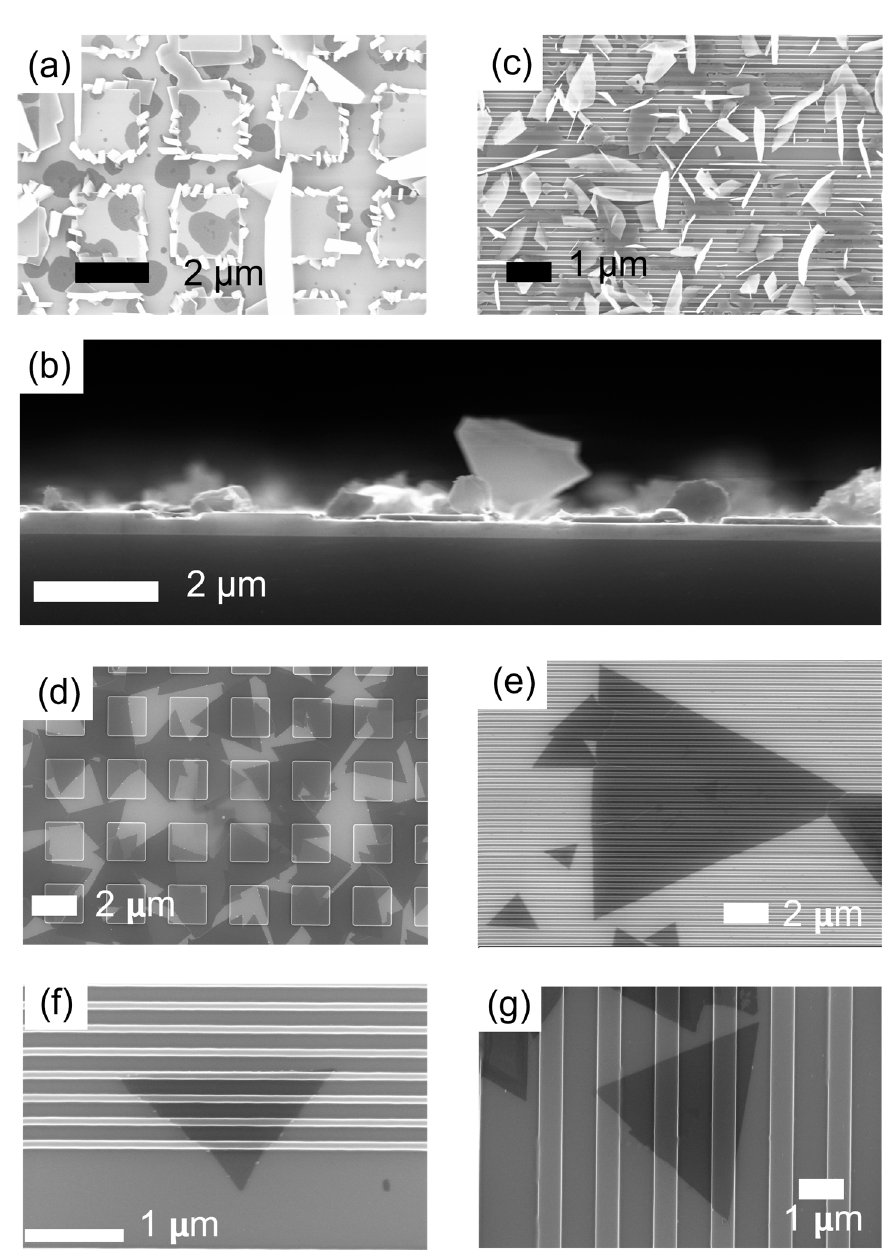
Figure 1. ( a – c ) Scanning electron micrographs showing the crystal morphologies for MoS 2 platelets formed on patterned SiO 2 substrates without the use of seeding promoters. In ( b ) an SEM cross- sectional view of the platelets is shown. ( d – g ) Scanning electron micrographs showing the in-plane morphologies of two-dimensional MoS 2 crystals formed on patterned SiO 2 substrates using perylene-based molecules as seeding promoters for the growth.